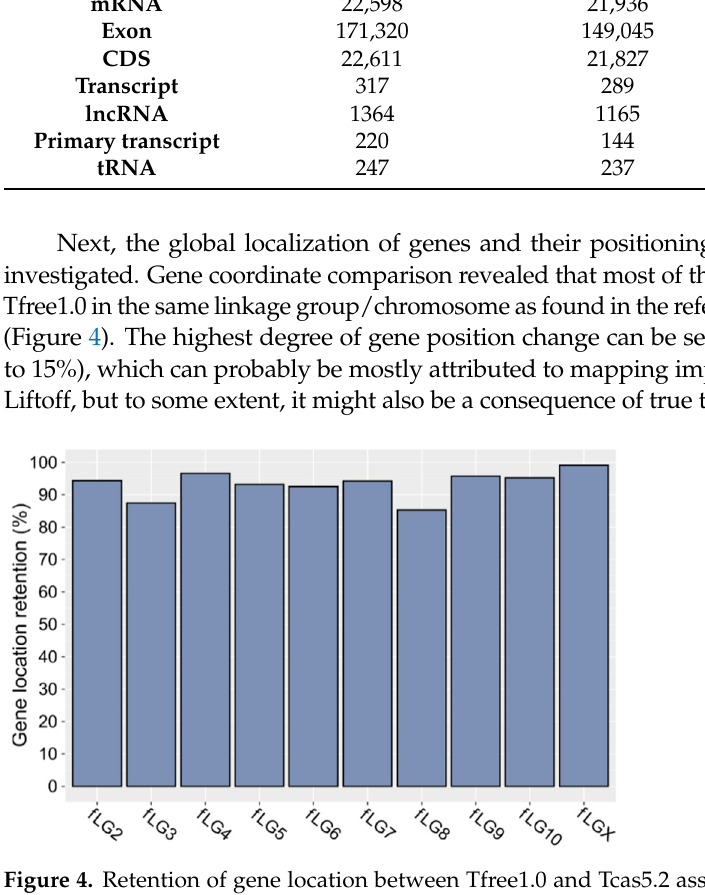
Table 3. Comparison of assembly annotations between the reference T. castaneum Tcas5.2 assembly and features lifted to the T. freemani Tfree 1.0 assembly.